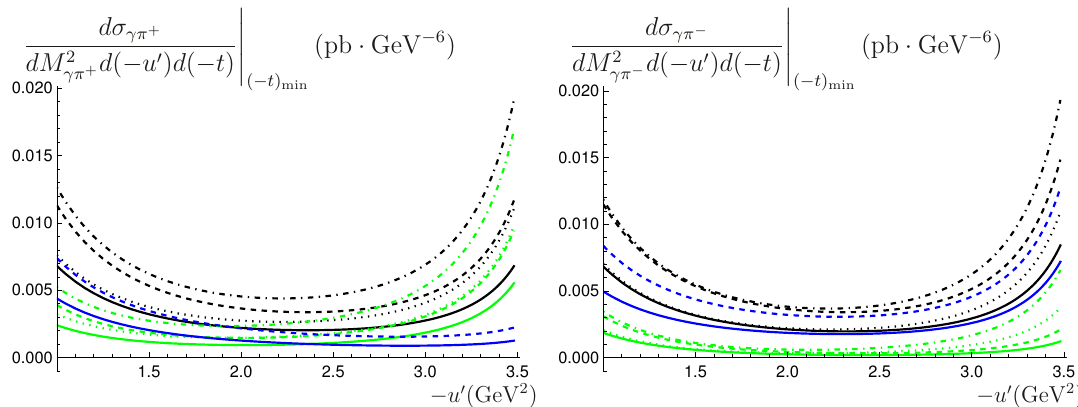
Figure 24 . The fully differential cross-section for π + ( π − ) is shown as a function of ( − u 0 ) on the left (right). The blue and green curves correspond to contributions from the vector and axial GPDs respectively. The black curves correspond to the total contribution, i.e. vector and axial GPD contributions combined. As before, the dashed (non-dashed) lines correspond to holographic (asymptotic) DA, while the dotted (non-dotted) lines correspond to the standard (valence) scenario. We fix S = 20000 GeV 2 and M 2 = 4 GeV 2 . Note that the vector contributions consist of only γN γπ two curves in each case, since they are insensitive to either valence or standard